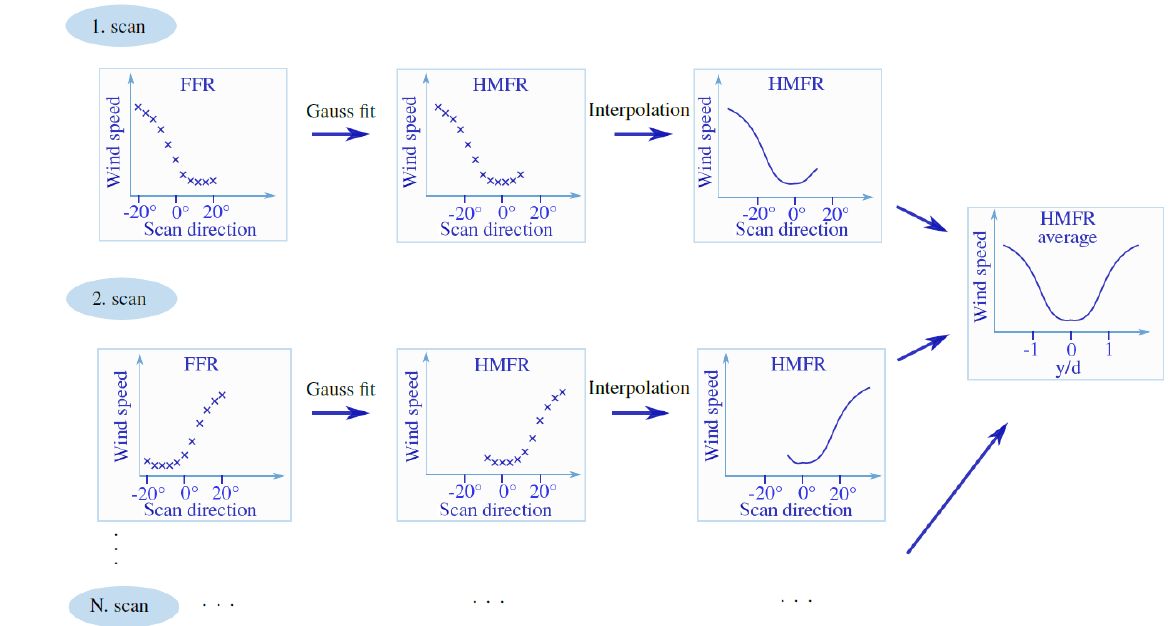
Figure 5. Method for the determination of the mean wind speed deficit in the